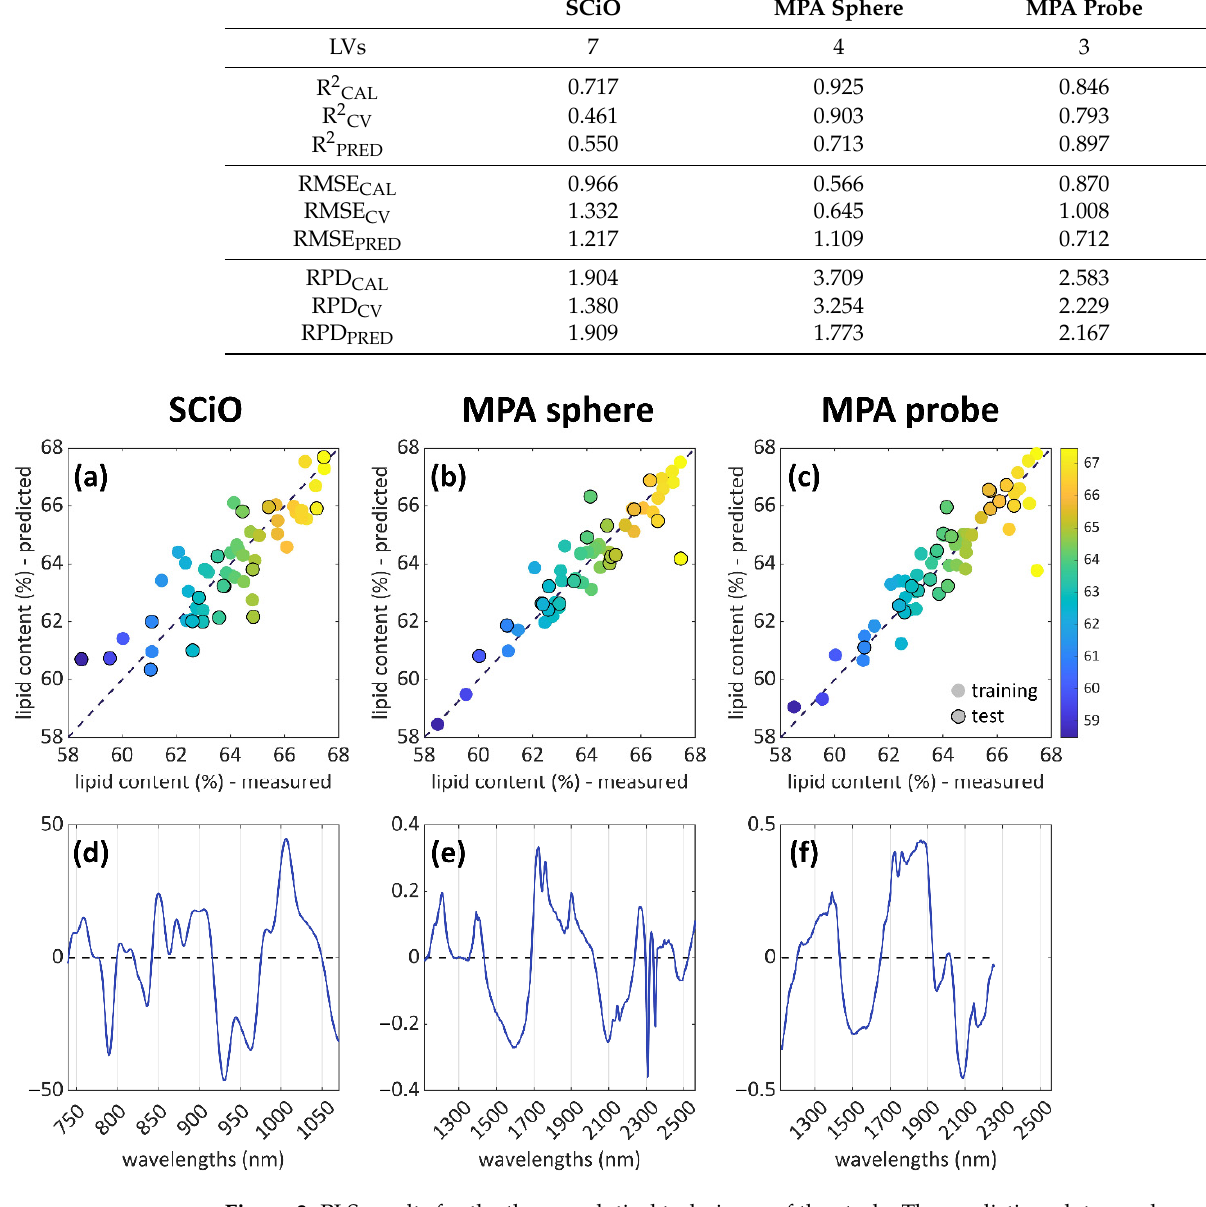
Figure 3. PLS results for the three analytical techniques of the study. The prediction plots are shown in the first row ( a – c ), with the samples coloured according to the lipid content. The black-bordered markers correspond to the test set (predicted samples). In the second row ( d – f ), the corresponding regression vectors are reported, showing the variables that are important for each PLS model.